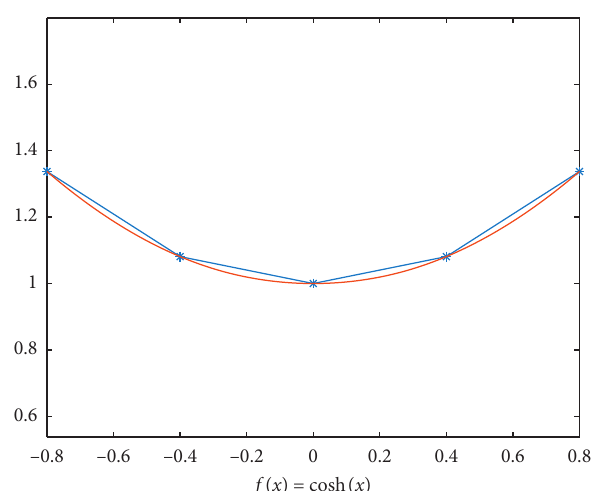
Figure 6: Limit curve by our scheme when lim initial polygon derives from semicircle.